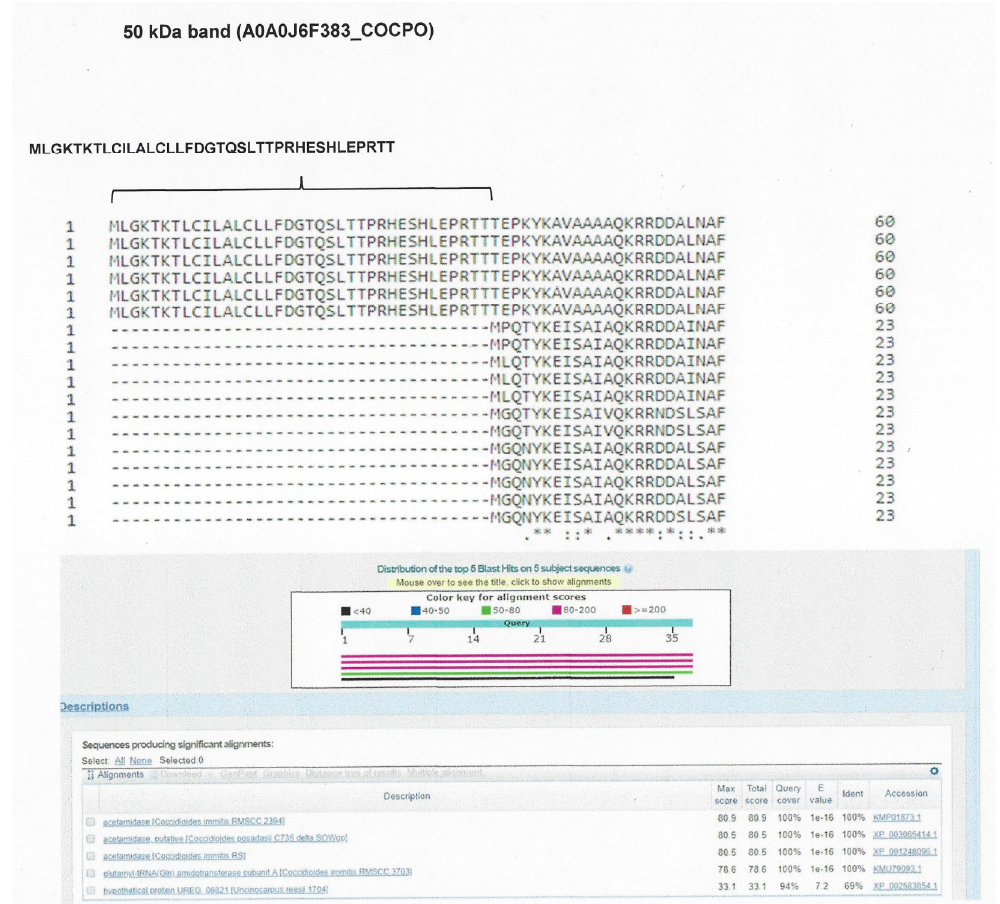
Figure 5. Alignment map with the BLAST protein program. The selected peptide of the assembled protein corresponding to the 50 kDa band is shown, identified through aligned sequences of Coccidioides spp. and related fungi. The selected peptide was compared through the BLAST program to confirm its